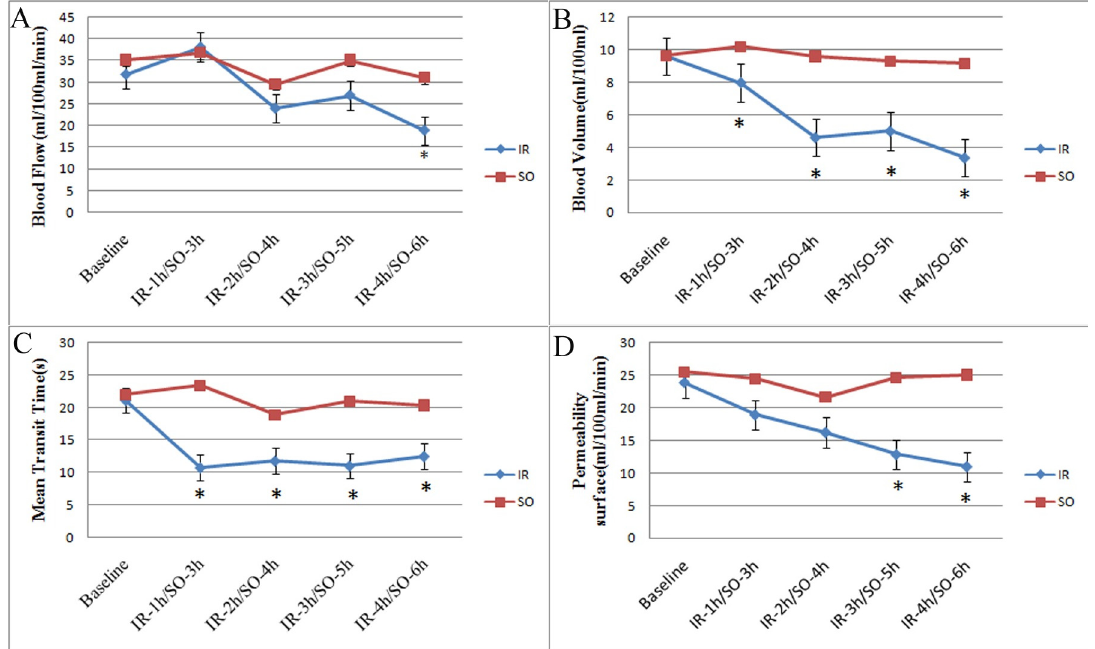
Fig 1. Perfusion parameters in ischemia-reperfusion(IR) animals and corresponding sham-operated(SO) animals. (A) BF in IR animals and corresponding SO animals. (B) BV in IR animals and corresponding SO animals. (C) MTT in IR animals and corresponding SO animals. (D) PS in IR animals and corresponding SO animals.Data are presented as median (n = 24 pigs in the IR group and n = 20 in the SO group: * p < 0.05VS time-matched